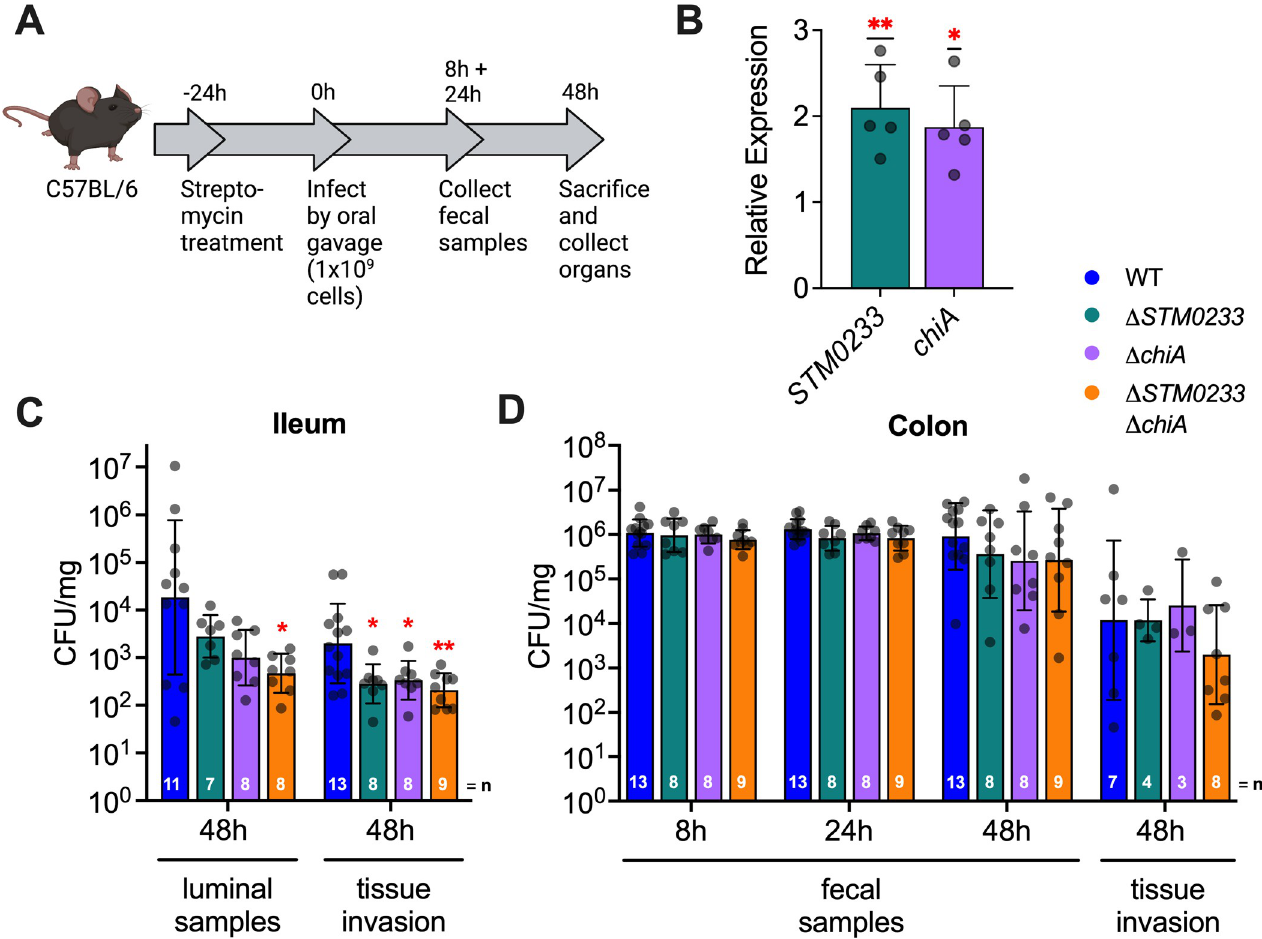
Fig 2. S . Typhimurium chitinases are required for the colonization and invasion of small intestinal epithelial cells in vivo . (A) Streptomycin pre-treatment mouse model of S . Typhimurium infection. (B) mRNA expression of S . Typhimurium chitinases extracted from colonic luminal samples collected 48 hpi. Expression is normalized to the housekeeping gene gmk . Expression is represented relative to mid-log expression in LB. n = 5. Bars represent mean ± SD. (C) Luminal samples from the terminal ileum were collected 48 hpi to determine S . Typhimurium colonization. Invasion was determined with a gentamicin protection assay performed on the terminal ileum. (D) S . Typhimurium colonies recovered from fecal samples collected at 8 and 24 hpi. Fecal samples at 48 hpi were collected directly from the lumen of the colon. Invasion of colonic tissue was determined with a gentamicin protection assay. Bars represent geometric mean ± geometric SD. Statistics: (B) one-sample t- test against our null hypothesis (relative expression = 1) (C-D) Stars indicate significance compared to the WT control by one-way ANOVA with Dunnett’s multiple comparison test. � = p < 0.05, �� = p < 0.01.